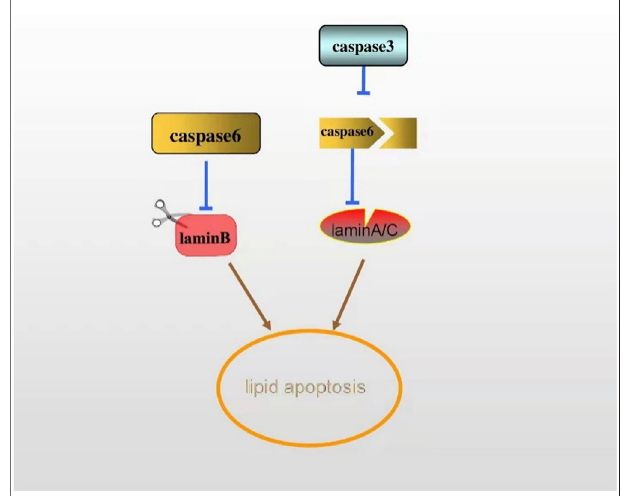
FIGURE 5| The early cleavage oflamin B by caspase-6 is regarded asa marker of apoptosis. Lamin A can also be a substrate of caspase-6. In apoptosis, caspase-6 is cleaved by caspase-3, thus cleaving lamin A/C, ultimately activating the